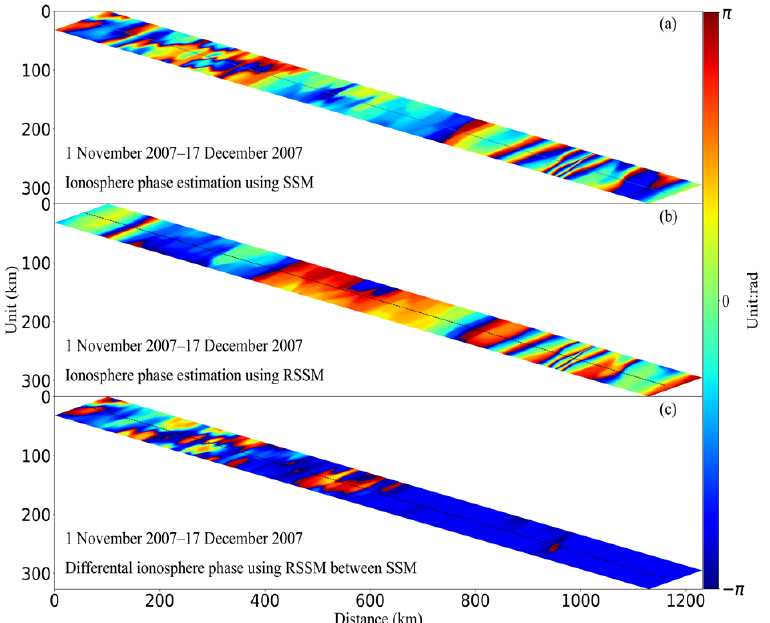
Figure 4. ALOS PALSAR data ionospheric estimation result. ( a ) Ionospheric phase (wrapped) estimated using SSM. ( b ) Ionospheric phase (wrapped) estimated using RSSM. ( c ) The ionospheric- phase bias between SSM and RSSM.